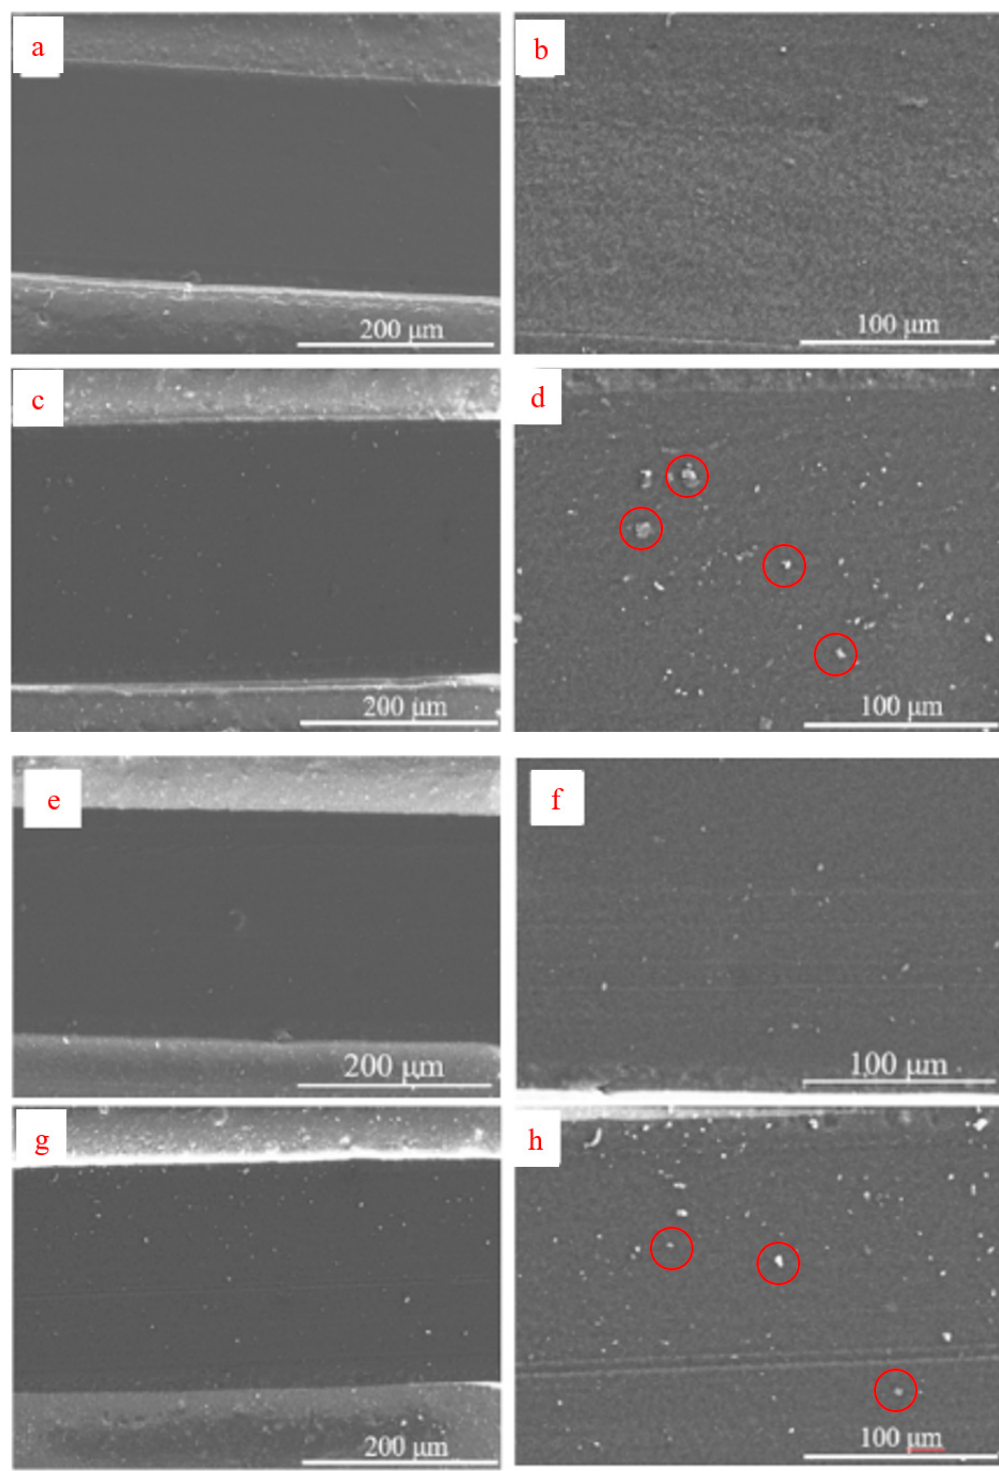
Figure 4. ( a , b ) SEM images, at different magnifications, of the flexible sensor’s conductive PDMS/CB blend layer at cross-section, before strain-cycling endurance test at 25 °C. ( c , d ) After 50% elongation strain-cycling endurance test at 25 °C. ( e , f ) Before strain-cycling endurance test at 37 °C. ( g , h ) After 50% elongation strain-cycling endurance test at 37 °C. Suspected carbon black particles are more visible in the higher magnification “after” images of ( d , h ). Red circles have highlighted selected particles to illustrate this.